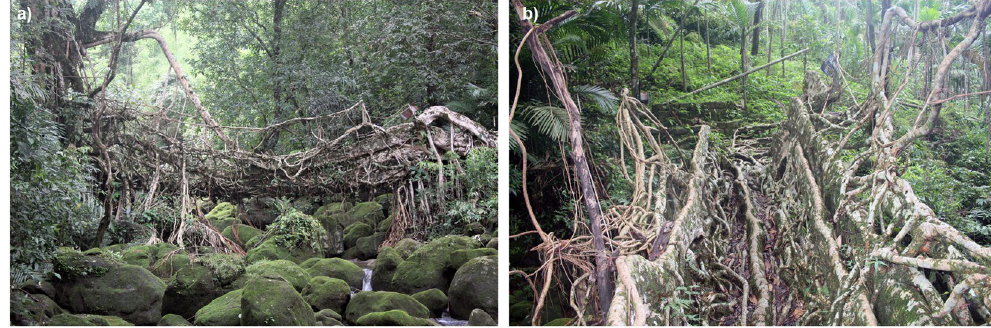
Figure 1. ( a ) Ummonoi Bridge, with a span of 7 meters, is a typical example of a mature living root bridge. Other bridges have spans up to 53 meters. ( b ) is taken from the centre of the bridge, looking towards the right- hand end of ( a ). (bridge #57 in Table S1 in Supplementary